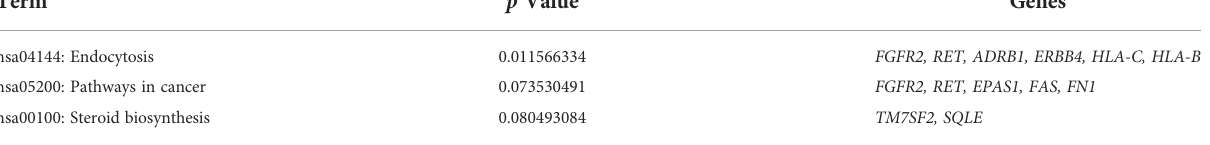
TABLE 2 KEGG pathway enrichment analysis of the overlapping DEGs.